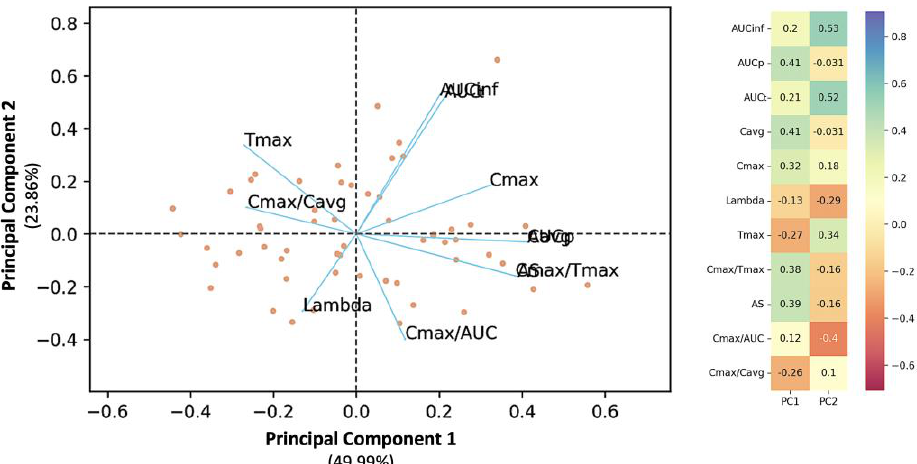
Figure 2. Principal component analysis for the pharmacokinetic parameters estimated from the actual bioequivalence study. Left panel: Biplot of the two principal components displaying the individual scores and the loadings (blue lines). Right panel: Loading values in the case of the first and second principal components (PC1 and PC2). A description of the pharmacokinetic parameters is provided in Table 1.